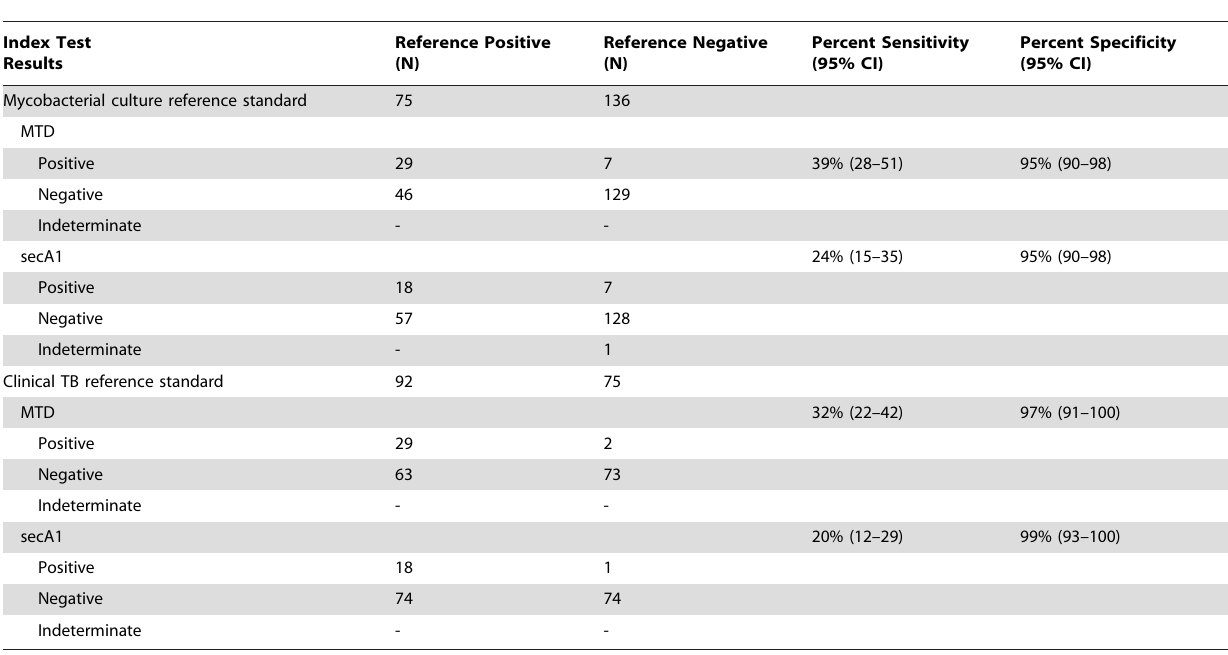
Table 2. Diagnostic performance of nucleic acid amplification tests for TB, compared to both the primary and secondary reference